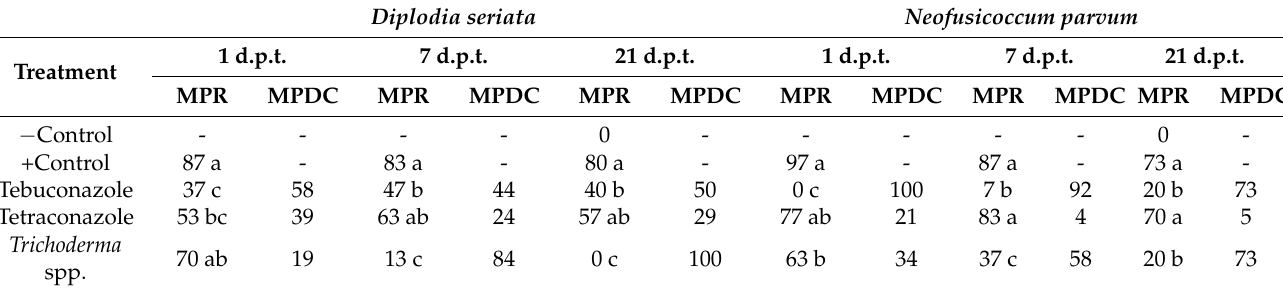
Table 5. Efficacy of commercial products applied immediately after pruning, followed by inoculation of 5000 conidia of either D. seriata or N. parvum 1 day, 7 days, and 21 days post-treatment in a detached cane assay experiment. Diplodia seriata Neofusicoccum